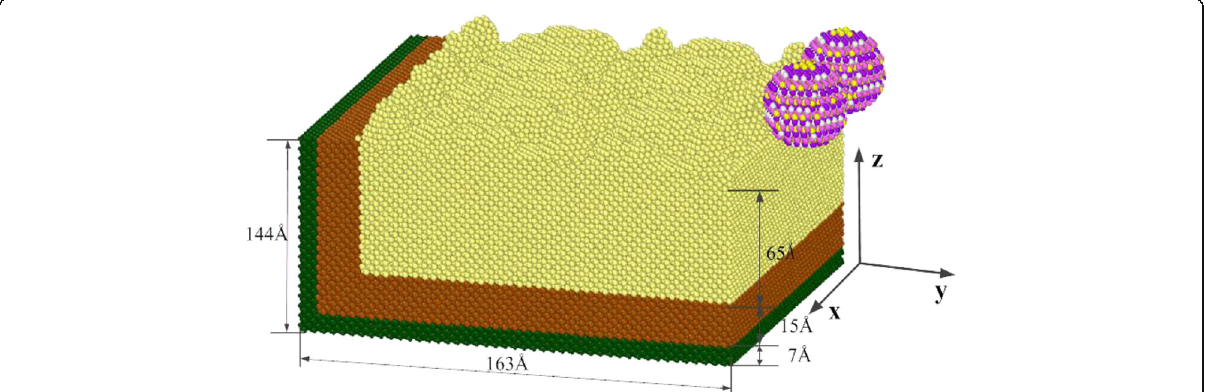
Fig. 2 Simulation model of SiC abrasive cutting single crystal copper. Figure 2 is about the simulation model of SiC abrasive cutting single crystal copper; we built two SiC abrasive for cutting single crystal copper. In the abrasive flow polishing experiment, the workpiece was usually cut with SiC abrasive. After the construction of SiC abrasive model, the molecular dynamics simulation of the workpiece was carried out. The model of two SiC abrasive cutting monocrystal copper with different angles was